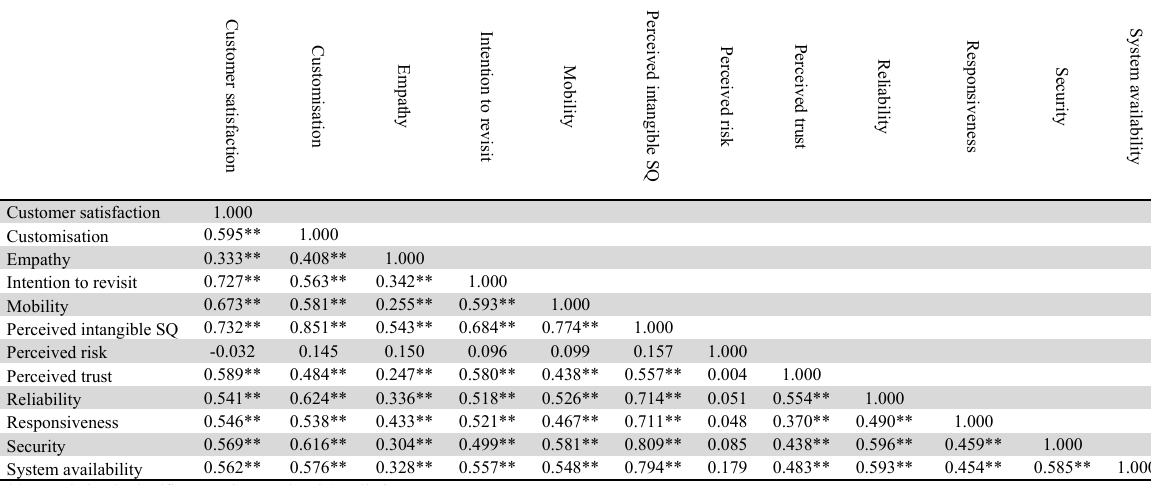
Customer satisfaction